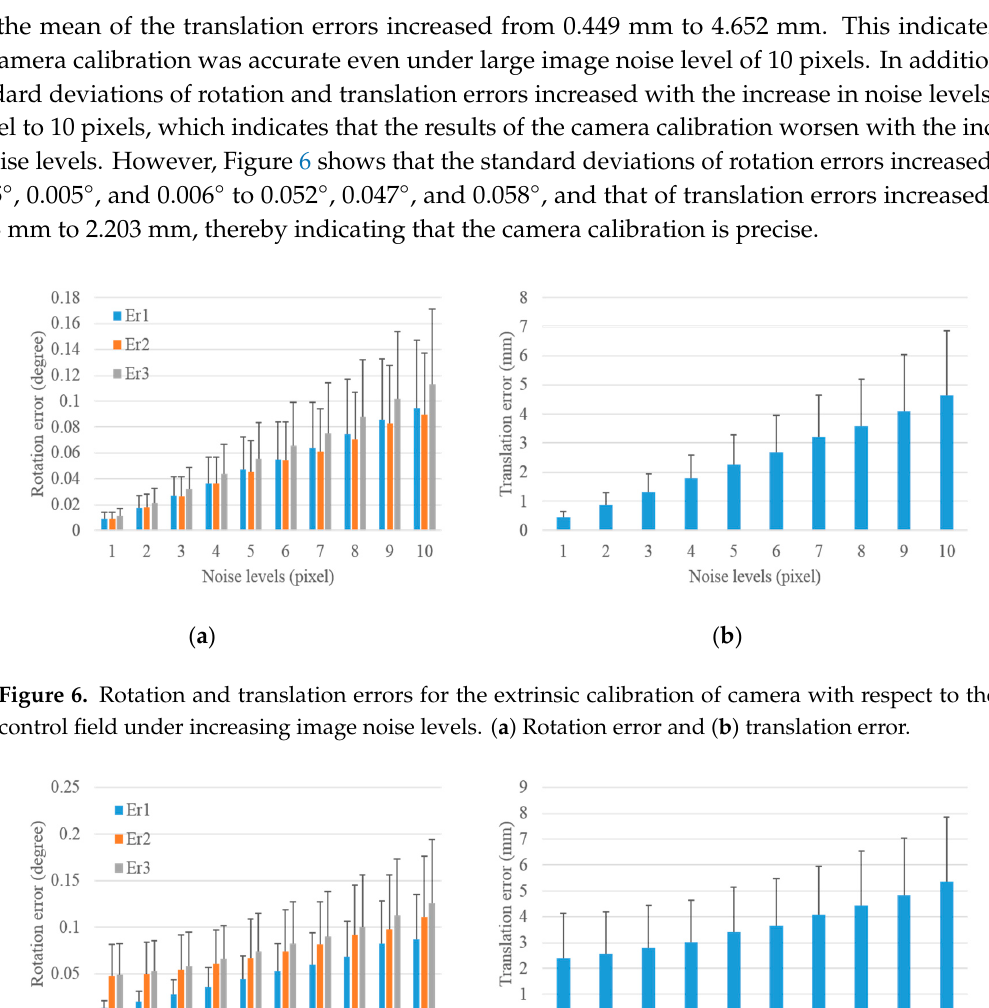
Figure 6. Rotation and translation errors for the extrinsic calibration of camera with respect to the control field under increasing image noise levels. ( a ) Rotation error and ( b ) translation error.